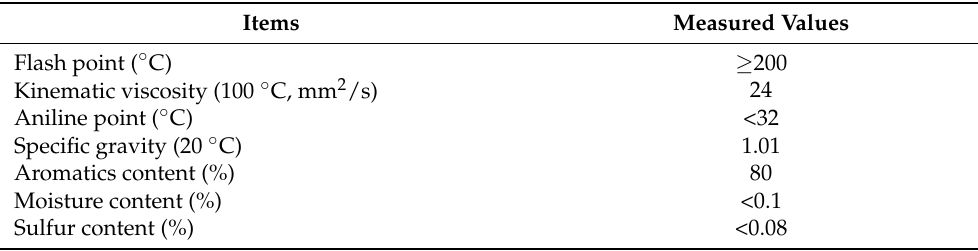
Table 1. Physical properties of lubricant by-products. Items Measured Values Flash point ( ◦ C) ≥ 200 Kinematic viscosity (100 ◦ C, mm 2 /s) 24 Aniline point ( ◦ C)